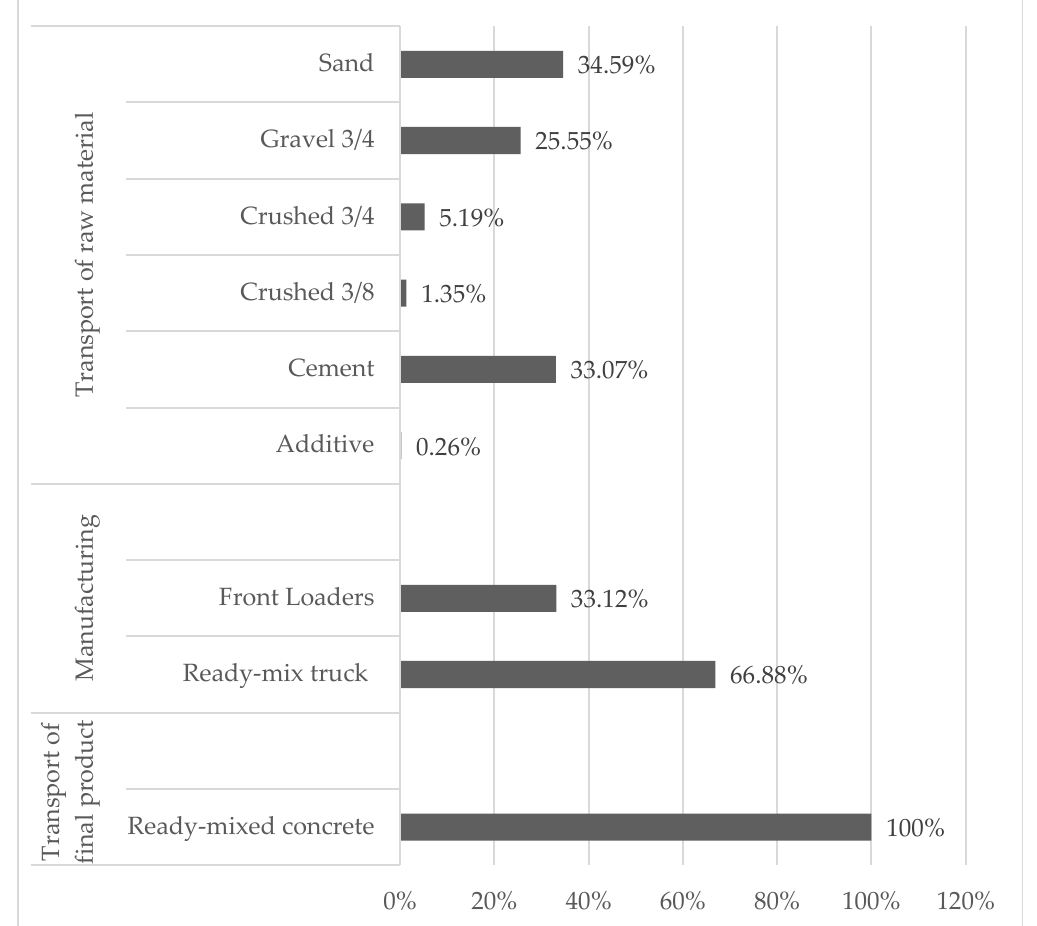
Figure 3. Annual fuel consumption by stages in relation to total consumption.